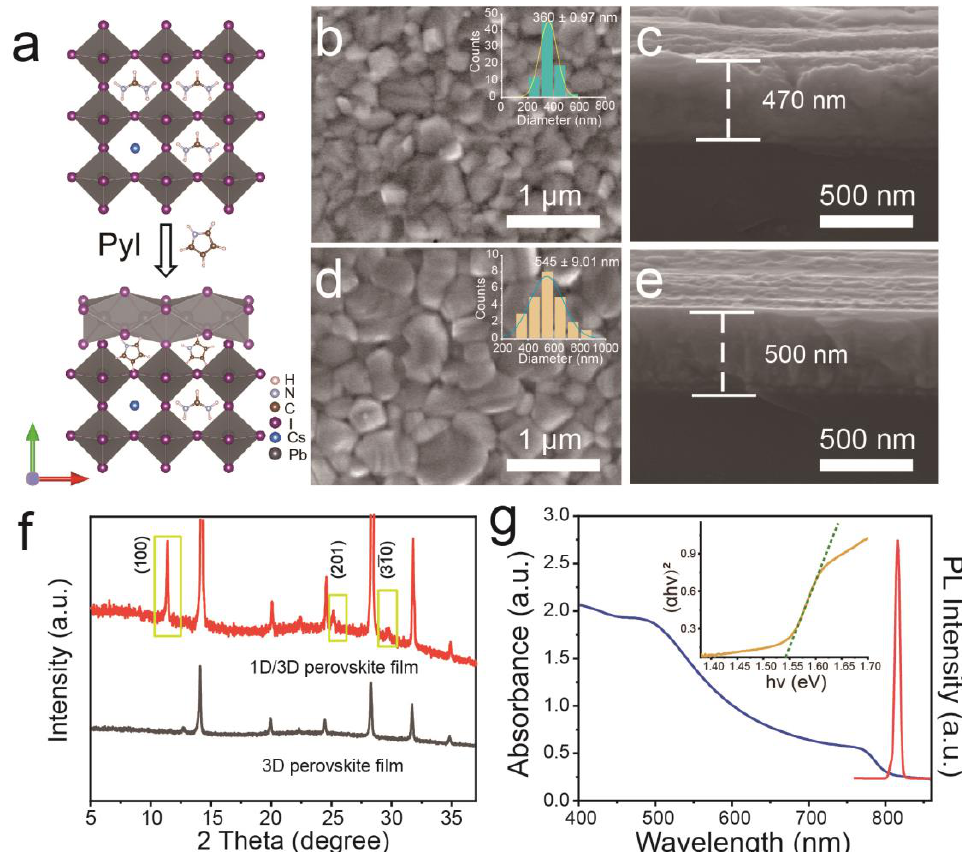
Figure 2. ( a ) Schematic diagram of 1D/3D PyPbI 3 /FACs crystal structure. Top-view ( b ) and cross-sectional ( c ) SEM images of 3D FACs perovskite film. The inset is the corresponding statistical diagram of grain size. Top-view ( d ) and cross-sectional ( e ) SEM images of 1D/3D PyPbI 3 /FACs perovskite film are shown. The inset in ( d ) is the statistical diagram of grains size for top-viewed PyPbI 3 /FACs. ( f ) XRD patterns of 3D and 1D/3D perovskite. ( g ) UV-vis and PL spectra and (inset) corresponding Tauc plot of 1D/3D PyPbI 3 /FACs perovskite film.